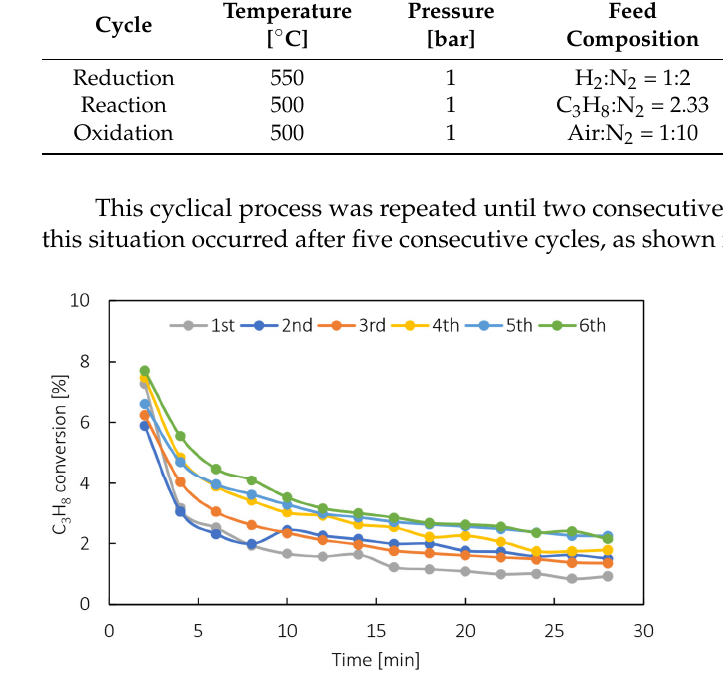
Figure A6. Propane conversion versus time for each reactive cycle performed for the catalyst stabi- lization (first 6